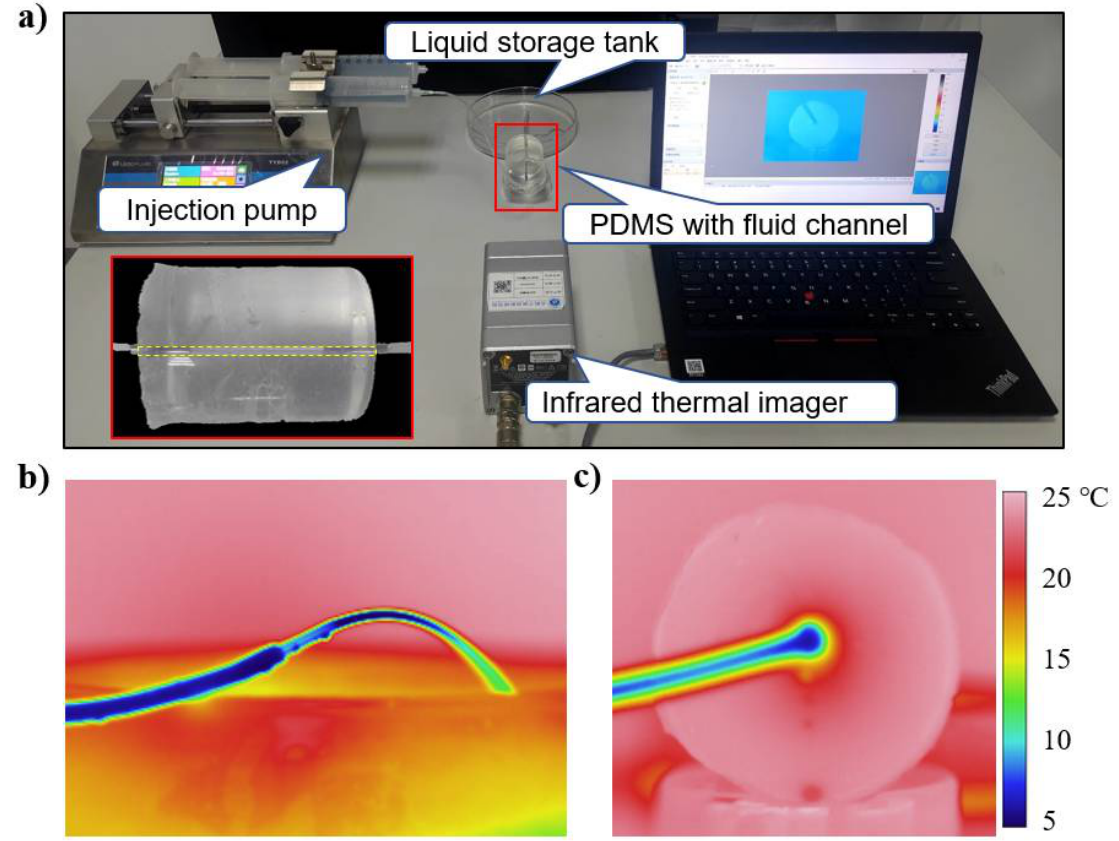
Figure 2. ( a ) Image of the experimental setup. ( b ) Thermal image at the inlet of channel. ( c ) Thermal image of the inlet surface.